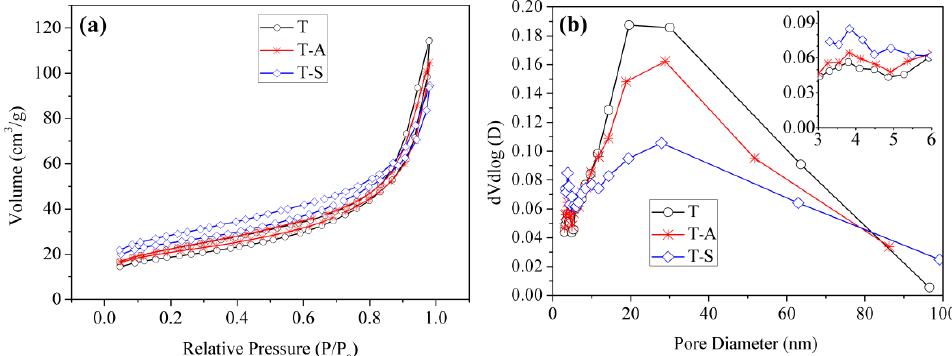
Figure 7. N 2 adsorption–desorption isotherms ( a ); and pore-size distribution curves ( b ) of the tobermorite